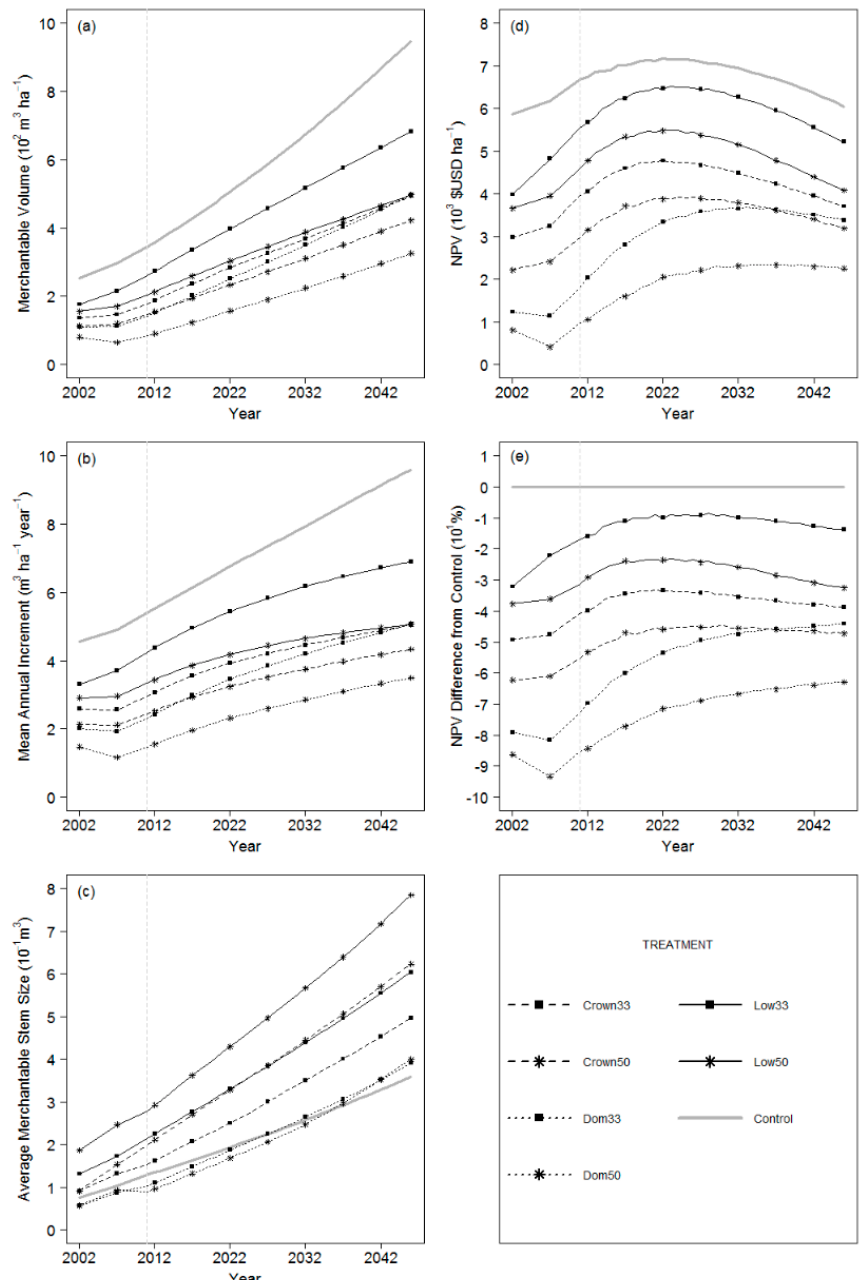
Figure 2. Average projection results across the various treatments for all sites: merchantable volume ( a ); mean annual increment ( b ); average merchantable stem size ( c ); net present value (NPV) ( d ); and percent difference in NPV from control ( e ).